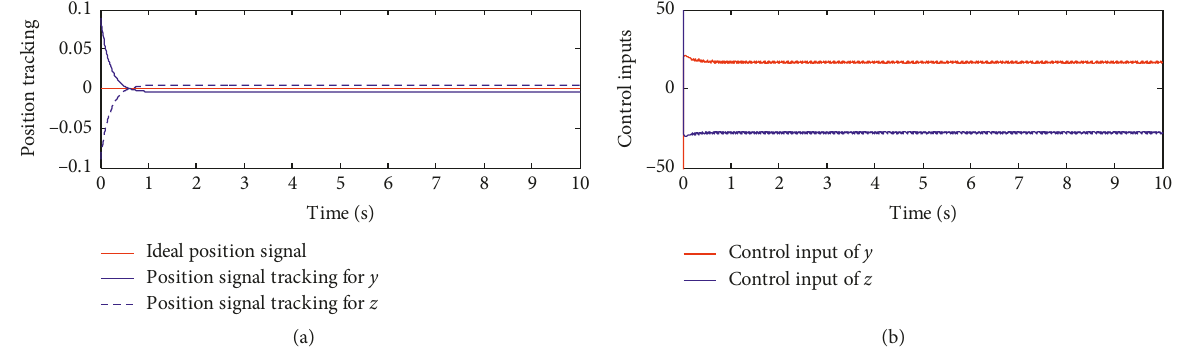
Figure 6: The position tracking signals for both y and z and corresponding control inputs under the condition of x